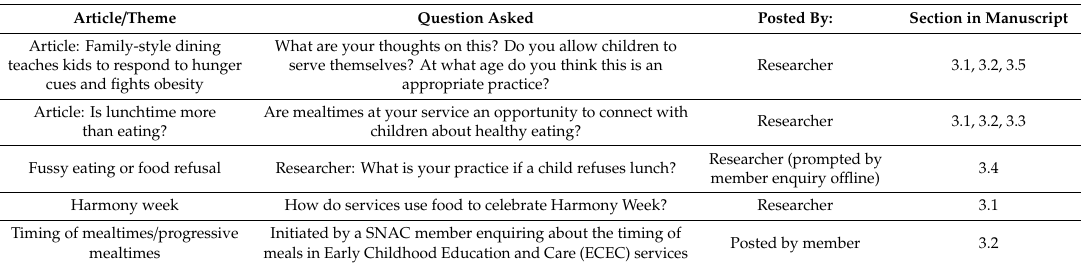
Table 2. Themes around food sharing / family-style mealtimes.